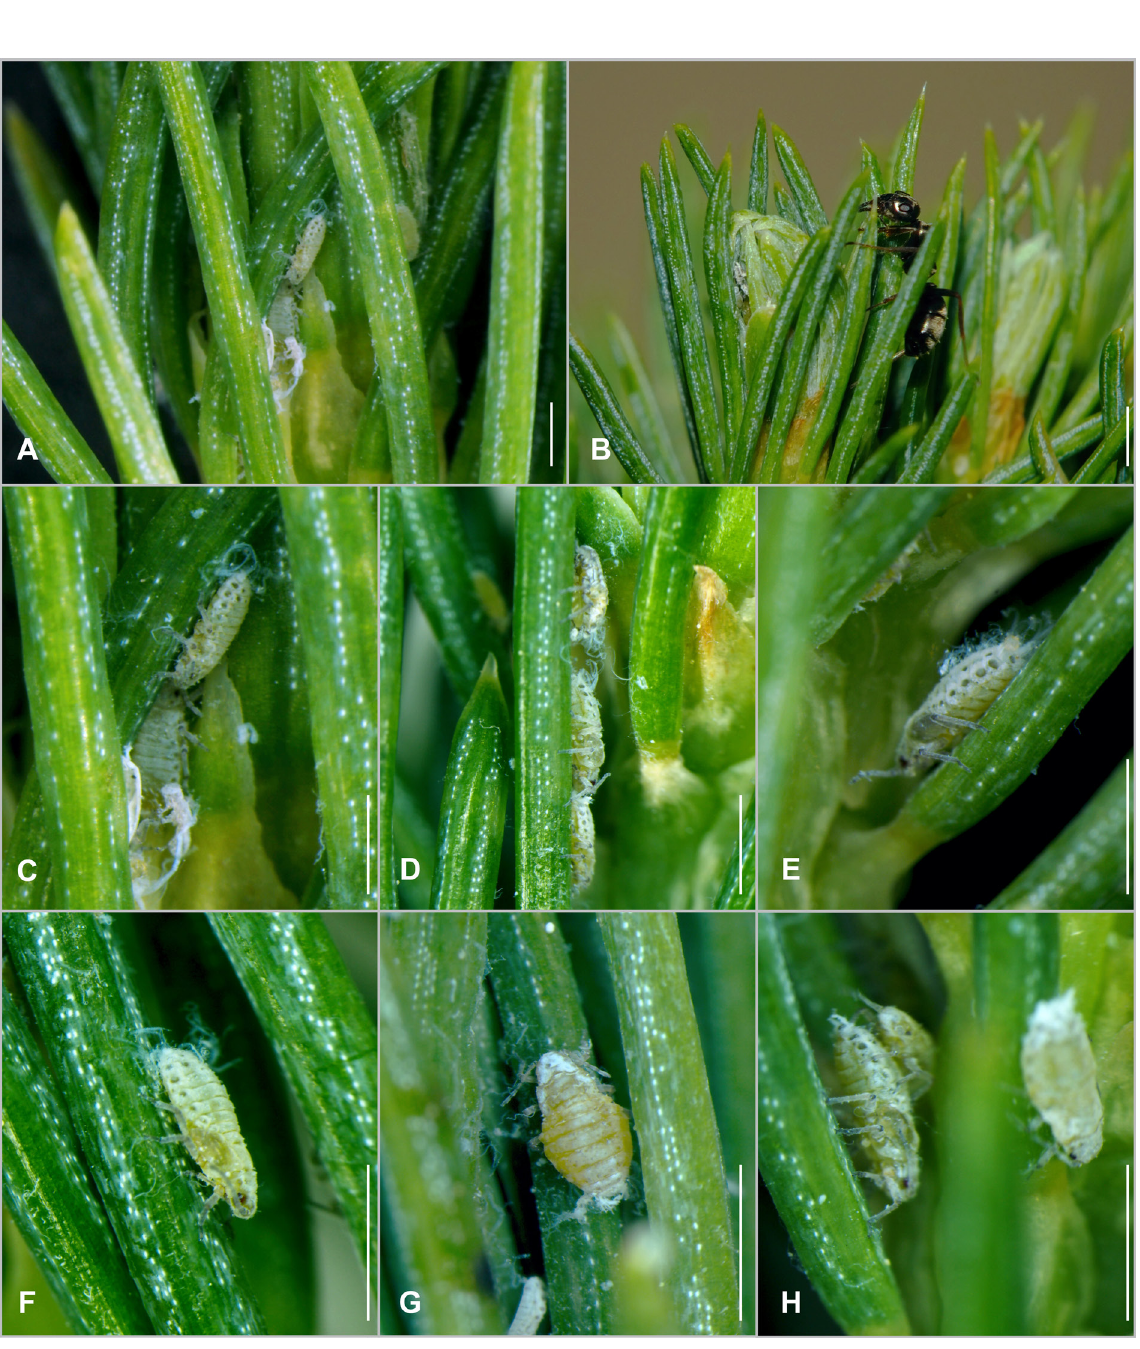
Fig. 27. Mindarus obliquus (Cholodkovsky, 1896), small colonies on Picea glauca. Apterae and young alatae (with wing pads). The ant in B is Lasius niger (Linnaeus, 1758). Scale bars: 1